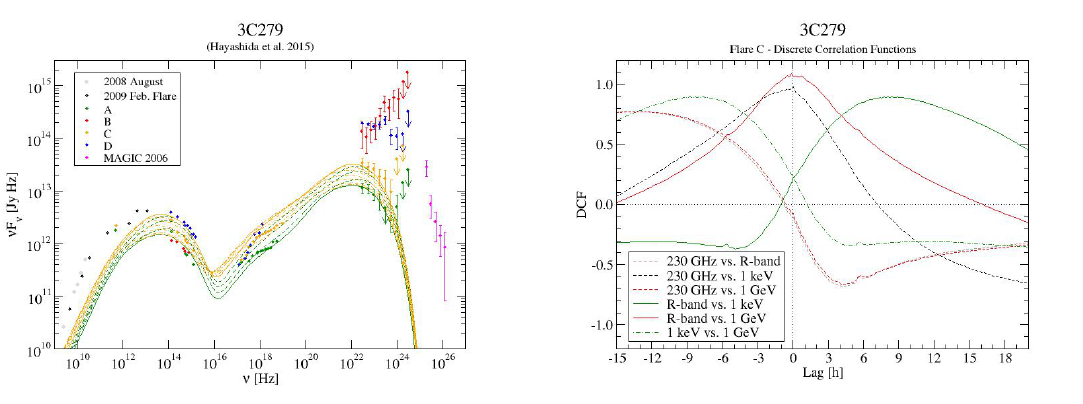
Figure 9. Shock-in-jet simulation of a flare of the FSRQ 3C279. Data are from [30]. Left : Snap-shot SEDs resulting from the time-dependent simulaton; Right : Cross-correlations between various frequency bands. Radio and X-ray variations are expected to lag behind optical and GeV γ -ray variations by ∼ 10 h. From Böttcher & Baring (2019, in